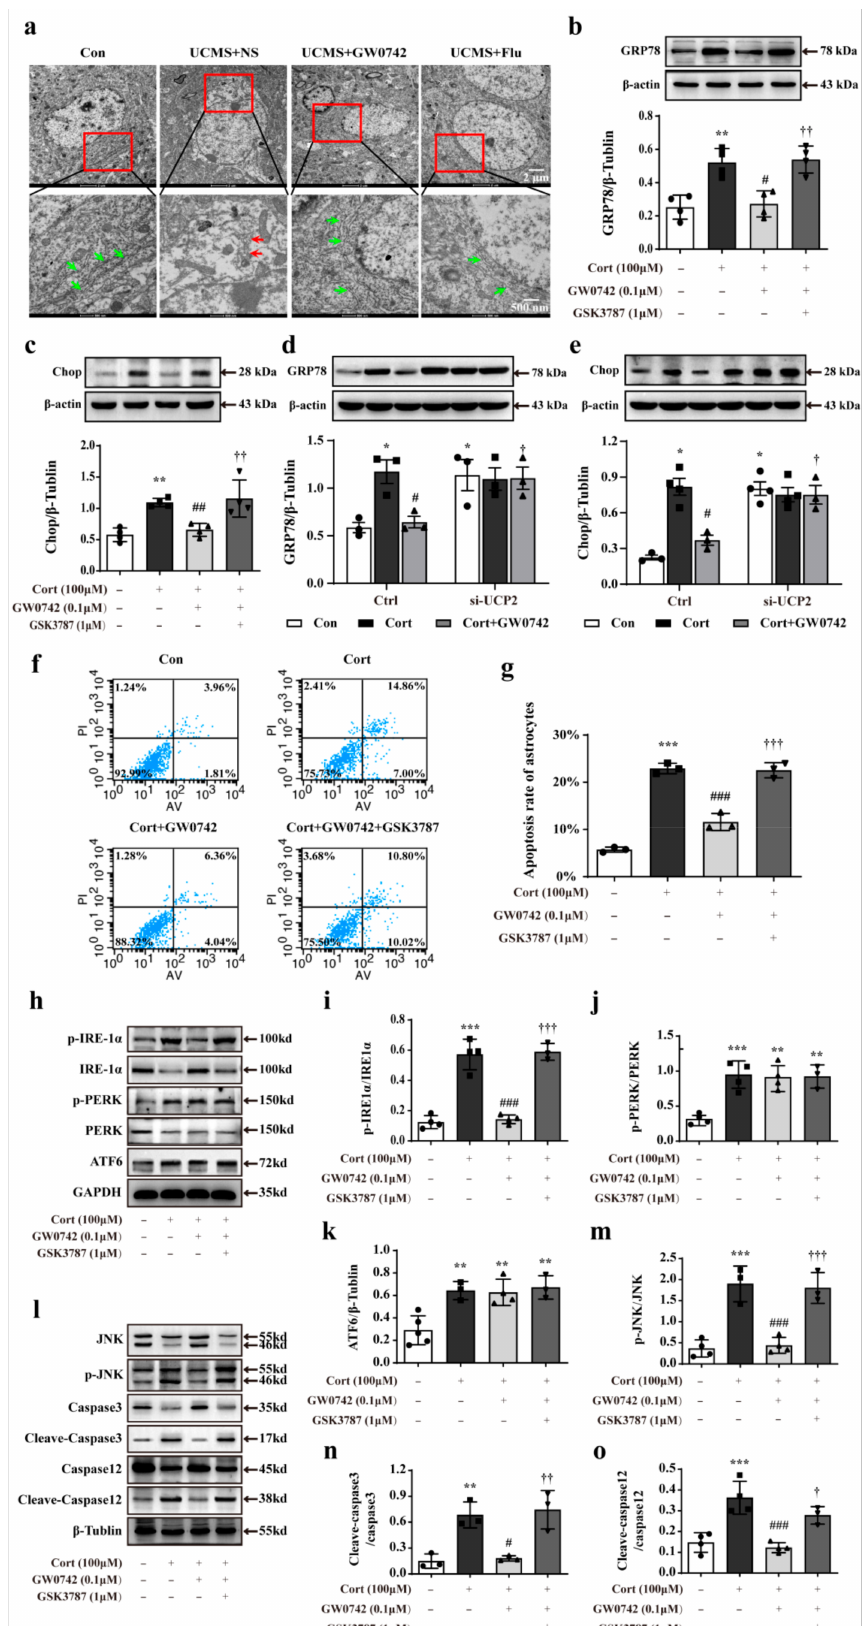
Figure 6. GW0742 reduces ER stress-induced astrocytic apoptosis induced by